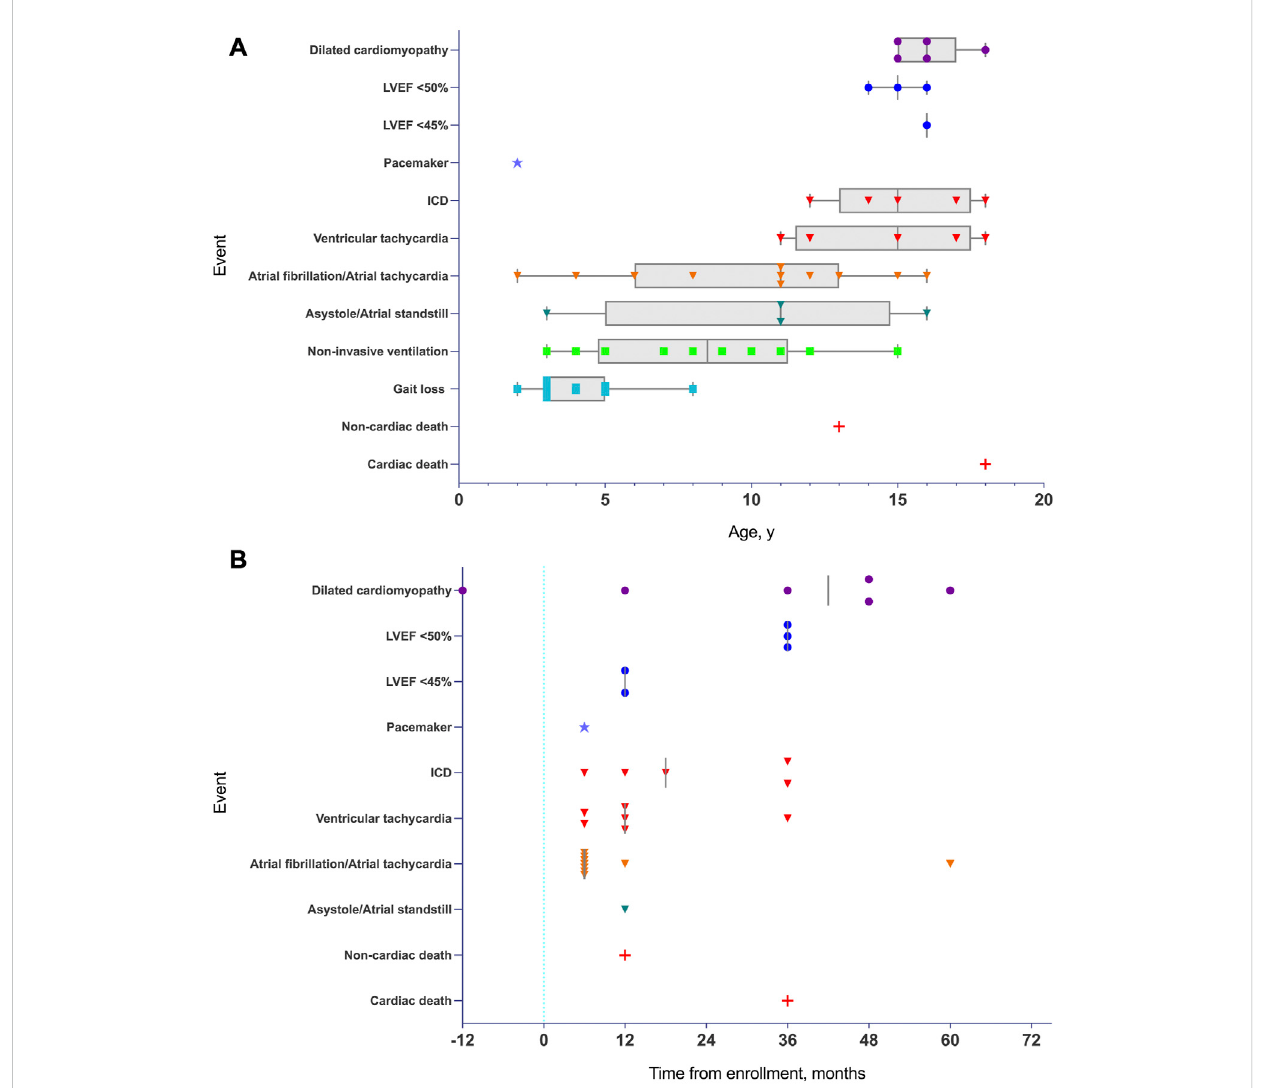
FIGURE 1 (A) : Timeline of major and minor events in pediatric patients with lamin-related muscular dystrophy de fi ned on the basis of age. Atrial arrhythmias, asystole/atrial standstill, and malignant arrhythmias preceded structural and cardiac functional abnormalities (DCM criteria or depressed LVEF). Median time values are represented by vertical grey line when required. DCM and LVEF are represented by a dot. Pacemaker are represented by a star. Arrhythmias and ICD are represented by an inverted triangle. Gait loss and NIMV are represented by a square, and death are represented by a cross. When required, minimum to maximum range age is represented in grey box and whiskers. Abbreviations: LVEF, left ventricular ejection fraction. (B) : Timeline of major and minor events in pediatric patients with lamin-related muscular dystrophy de fi ned on the basis of enrollment (time 0 is the time of enrollmentrepresented byavertical bluedottedline).Median time valuesarerepresented by avertical greyline. DCMand LVEF are represented byadot, pacemakeris represented byastar, arrhythmiasand ICD are represented byan inverted triangle and death isrepresented byacross. Abbreviations:LVEF, left ventricular ejection